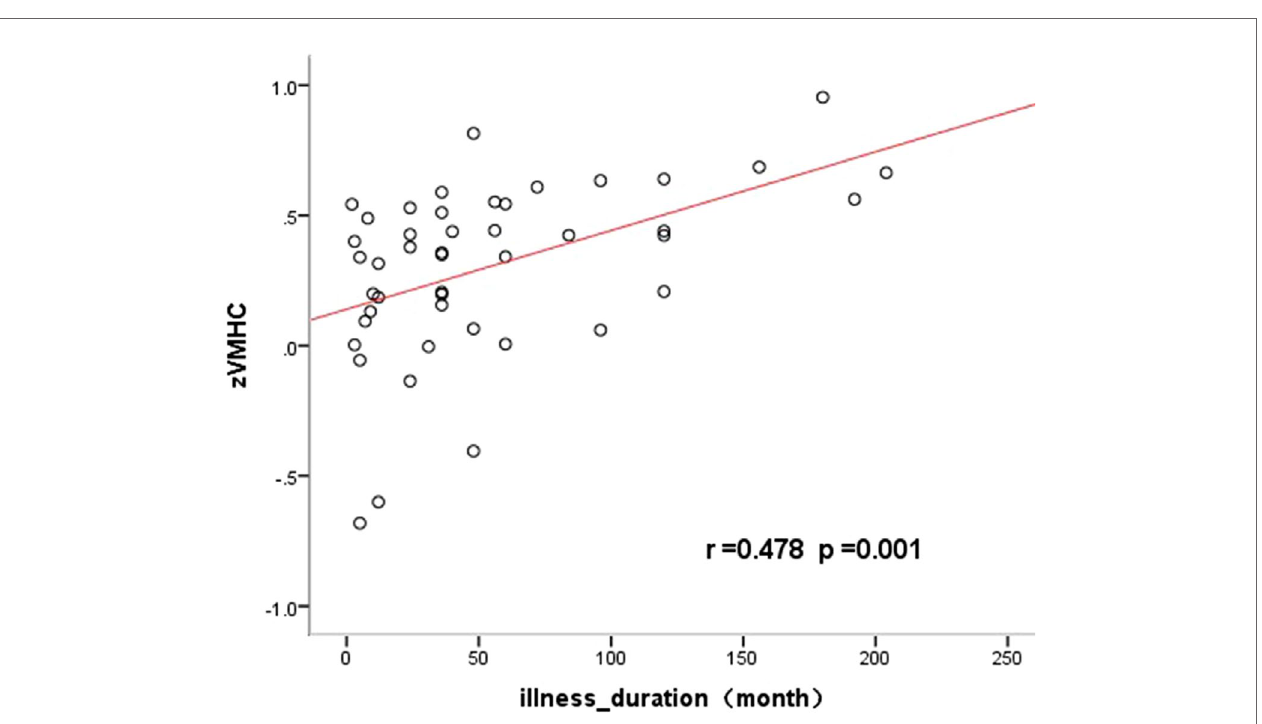
FIGURE 3 | Significantly positive correlations between the VMHC values and the illness duration in the angular gyrus/middle occipital gyrus in OCD.